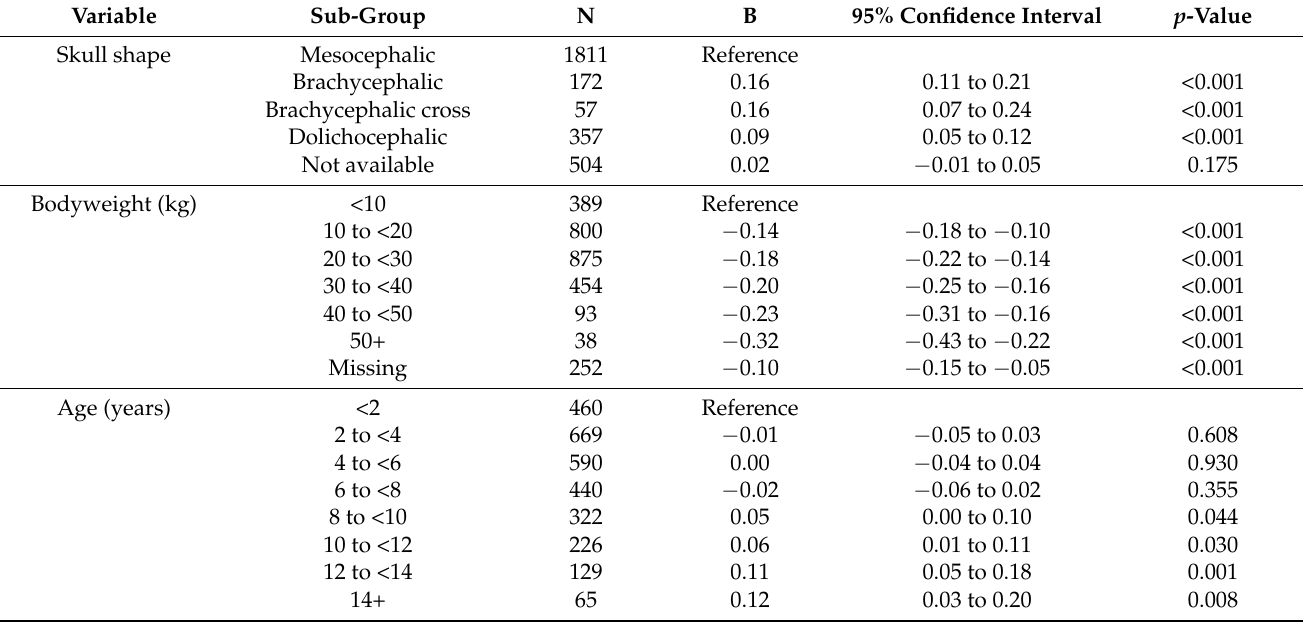
Table 5. Variables influencing owner perception of winter weather effects on canine activity score. Factors with a positive B value increased the winter weather effects score and factors with a negative B value decreased the winter weather effects